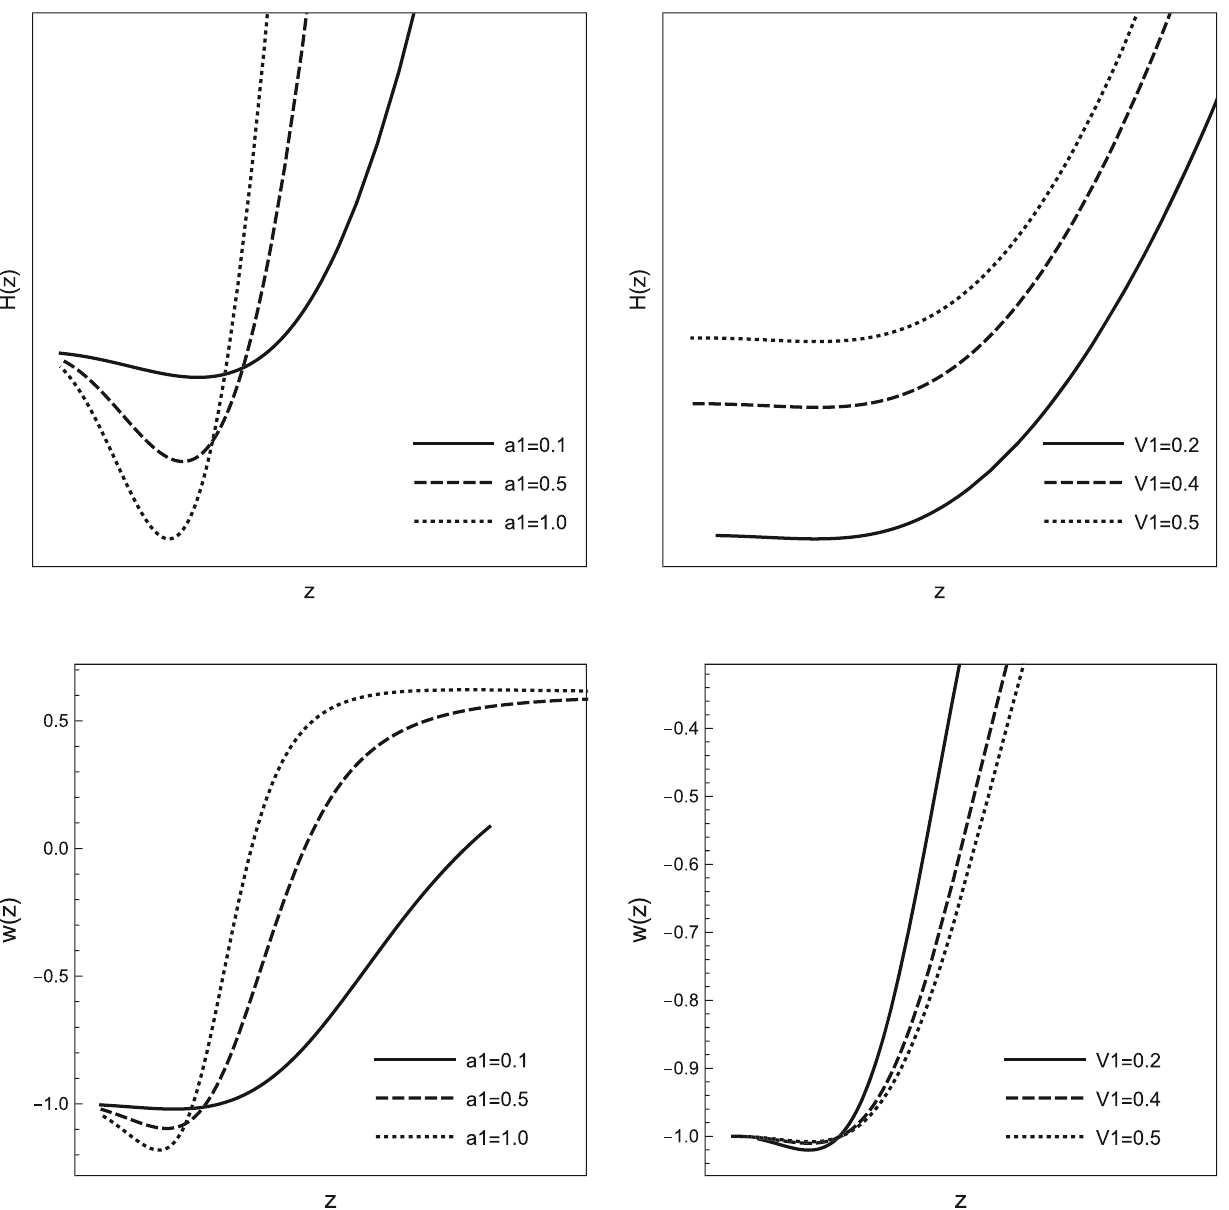
Fig. 2 Qualitative evolution for the Hubble function H ( z ) and for ered a 0 = 1. Left figures are for V 1 = 0 . 2 and different values of a 1 = {− 0 . 1 , 0 . 5 , 1 } . Right figures are for a 1 = 0 . 1 and different values the equation of state parameter w ( z ) for the total fluid for the scale factor (71) which holds for B 0 = 1 of V 1 = { 0 . 2 , 0 . 4 , 0 . 5 . For the figures we consid- 16